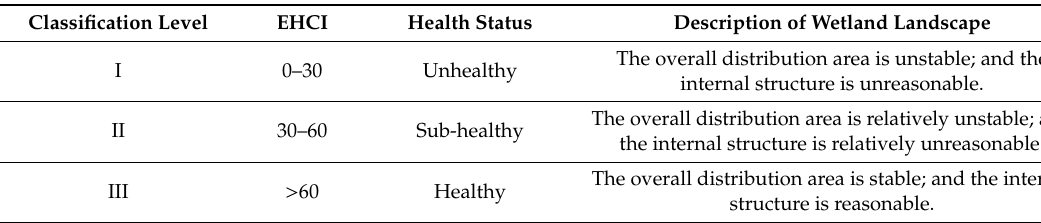
Table 3. The Classification of the EHCI of Poyang Lake